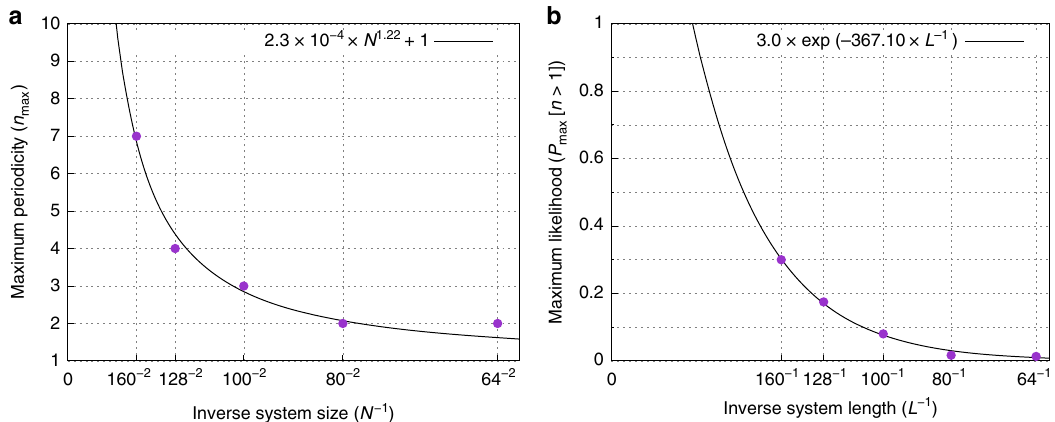
Fig. 6 Trends of the zero temperature multiperiodic behavior of the limit cycles with increasing system size. a Maximum period of limit cycles. In a , we plot the maximum period of the limit cycles observed in Fig 5a – e, as a function of 1/ N (purple circles). The black line is a fi t to the simulation results. The trend is toward divergence of the period of limit cycles in the thermodynamic limit. b Maximum likelihood of multiperiod limit cycles. In b , we plot the maximum likelihood of multiperiodic limit cycles, obtained from the peak heights of the left-hand panels in Fig. 5 (purple circles). The black line is a fi t to the simulation results. The trend is toward saturation of the likelihood of multiperiod behavior in the thermodynamic limit.